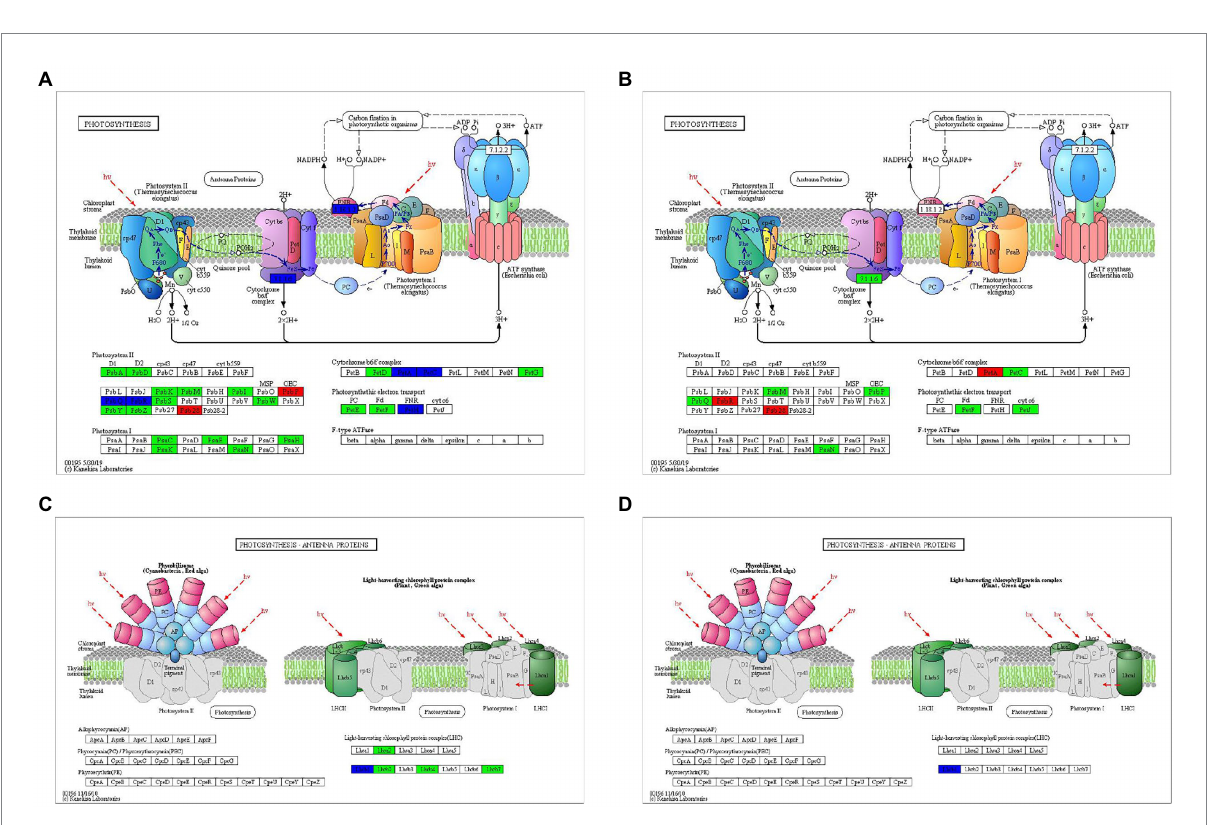
FIGURE 8 DEGs involved in photosynthesis during rehydration. DEGs involved in the “photosynthesis” pathway after rehydration in CK (A) and Mu (B) . DEGs involved in the “photosynthesis-antenna proteins” pathway after rehydration in CK (C) and Mu (D)